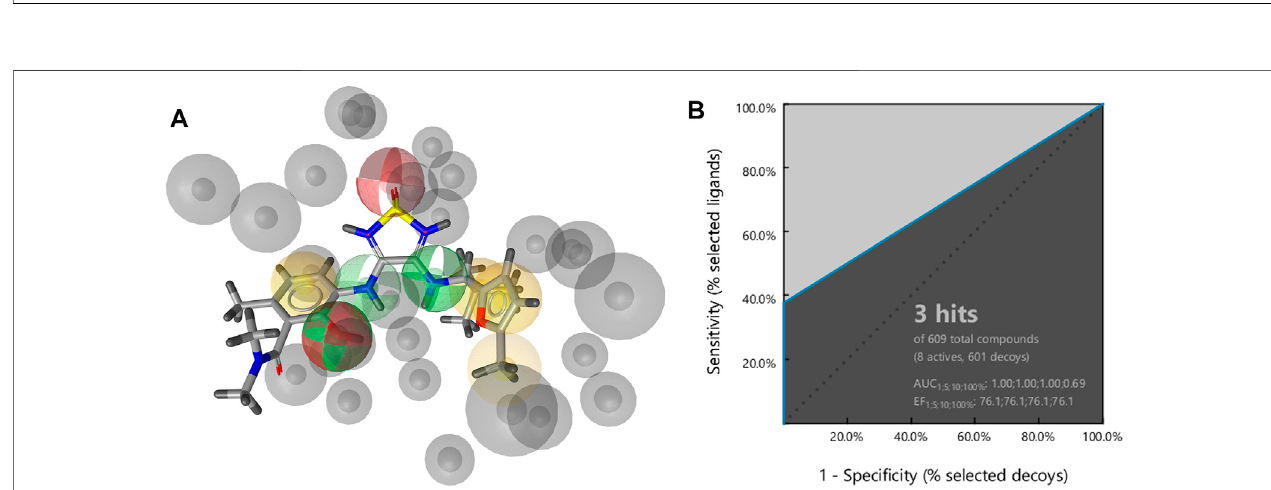
FIGURE 6 | (A) Structure-based pharmacophore model with four hydrophobic features (yellow spheres), two hydrogen bond acceptors (red spheres), three hydrogen bond donors (green spheres), and exclusion volumes (gray spheres) de fi ning restricted regions based on the shape of the binding site residues. Optional features are marked as dashed (B) Resulting ROC plot from virtual screening of 609 compounds (8 active compounds and 601 generated decoys). TP = true positives; FP = false positives; AUC = area under the curve; EF = enrichment factor.